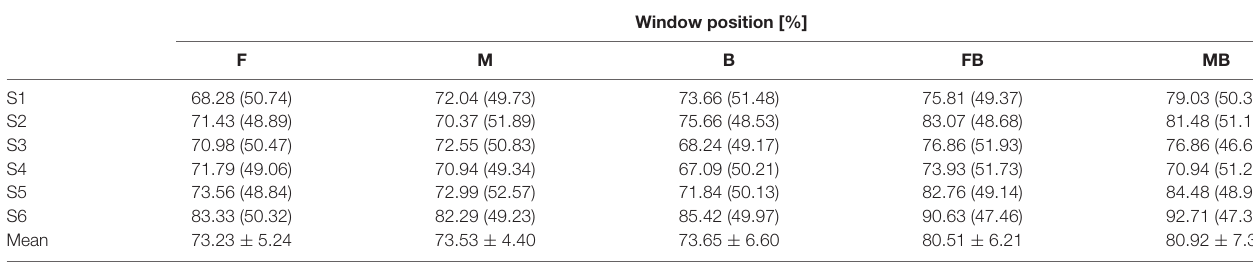
TABLE 2 | Classification accuracies for left vs. right (control).